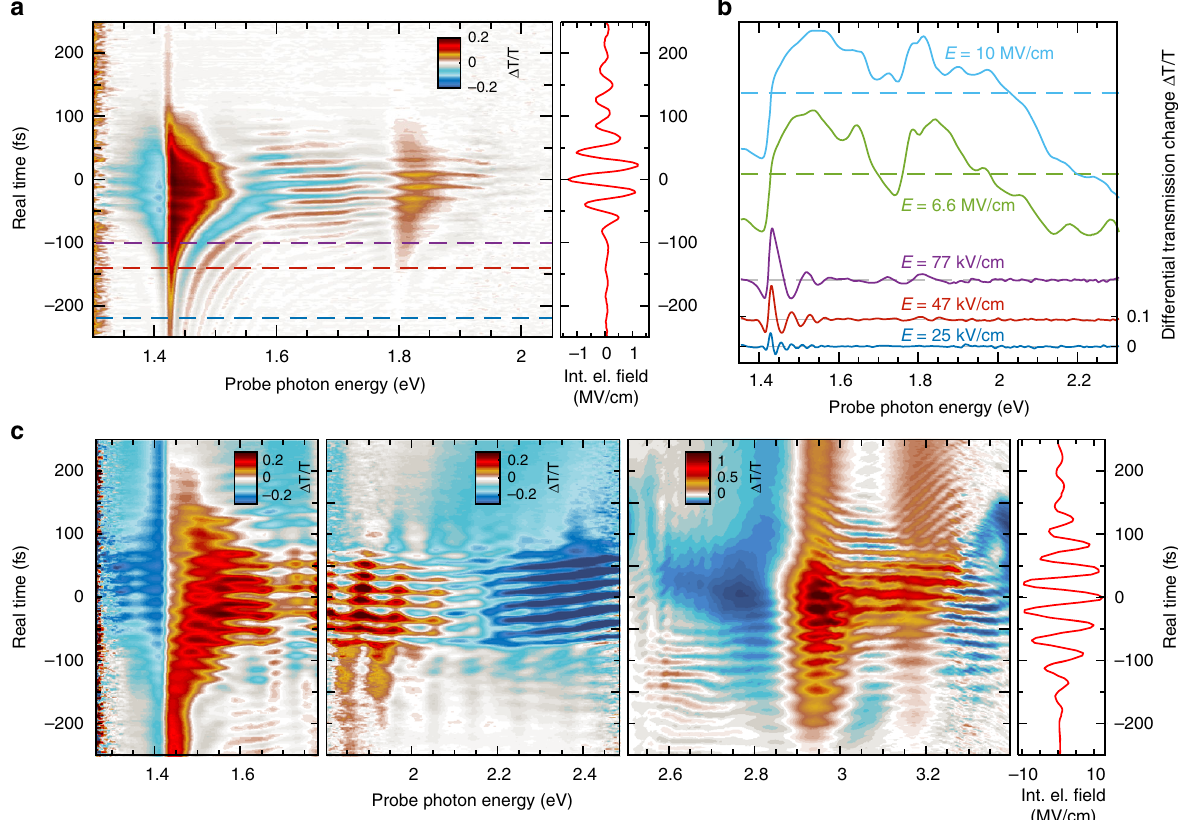
Fig. 2 Subcycle electroabsorption of intrinsic GaAs. a Moderate fi eld level. Left: Differential transmission changes, Δ T / T , color-coded as a function of probe photon energy and time; right: electric fi eld (red) of biasing mid-infrared transient with maximum amplitude of 1.4 MV/cm as a function of time. b Temporal slices of Δ T / T as a function of probe photon energy, as taken along different contours with constant electric fi eld amplitudes E . c Intense electric fi eld level. Left three panels: Δ T / T color-coded as a function of probe photon energy and time, as measured with three different probe spectra depicted in Supplementary Fig. 1b. Data above 2.5 eV were obtained with a GaAs epitaxial fi lm of 100 nm thickness, while all other spectra were measured on a 400-nm-thick sample; right: electric fi eld trace (red) of biasing transient with maximum amplitude of 12